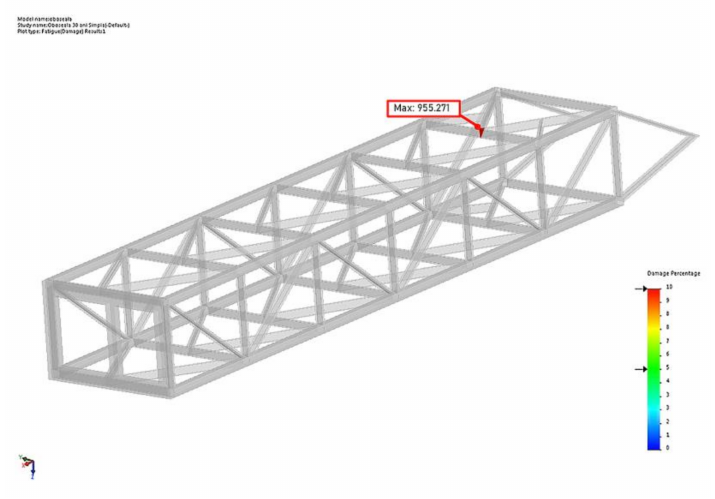
Figure 27. Damage variation line for 29 to 30 years period.